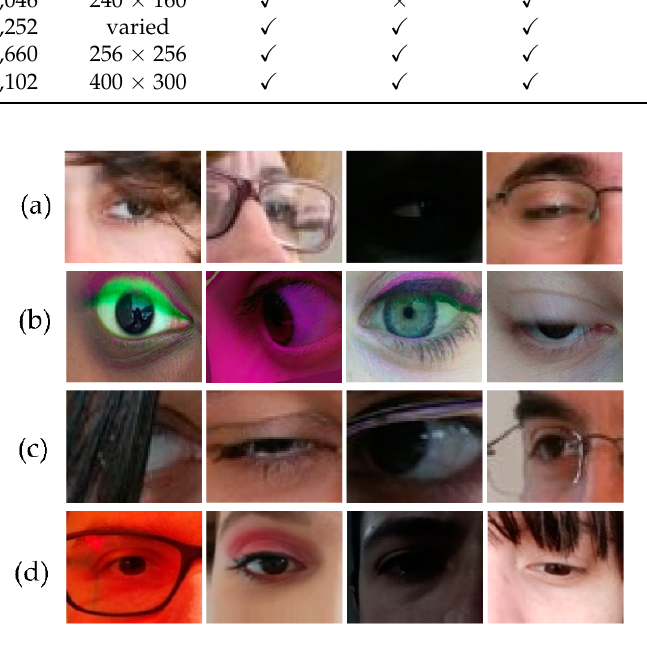
Figure 6. Sample images from: ( a ) UBIPr ( b ) VISOB ( c ) UBIRIS.v2. ( d ) UFPR .